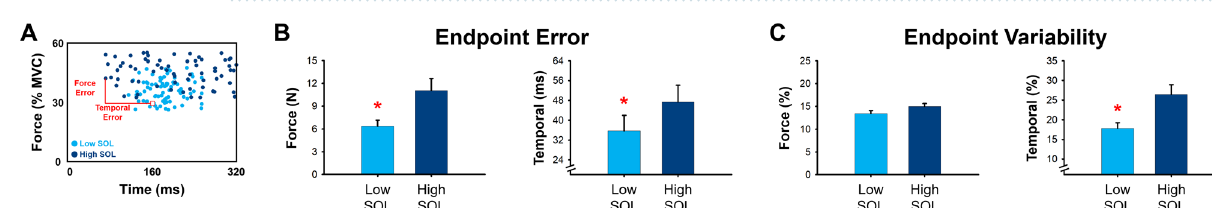
Figure 6. Endpoint control for young adults using a Low SOL and High SOL coordination pattern. A Low SOL coordination pattern resembled the one used by young adults, whereas a High SOL coordination pattern resembled the one used by older adults in Experiment 1. Representative example for young adults using a Low SOL and High SOL coordination pattern ( A ). When young adults performed the goal-directed ankle dorsiflexion contraction using a High SOL coordination pattern, they exhibited greater force and temporal ( B ) error. Furthermore, young adults exhibited greater temporal variability but similar force variability with the High SOL coordination pattern ( C ). *p <